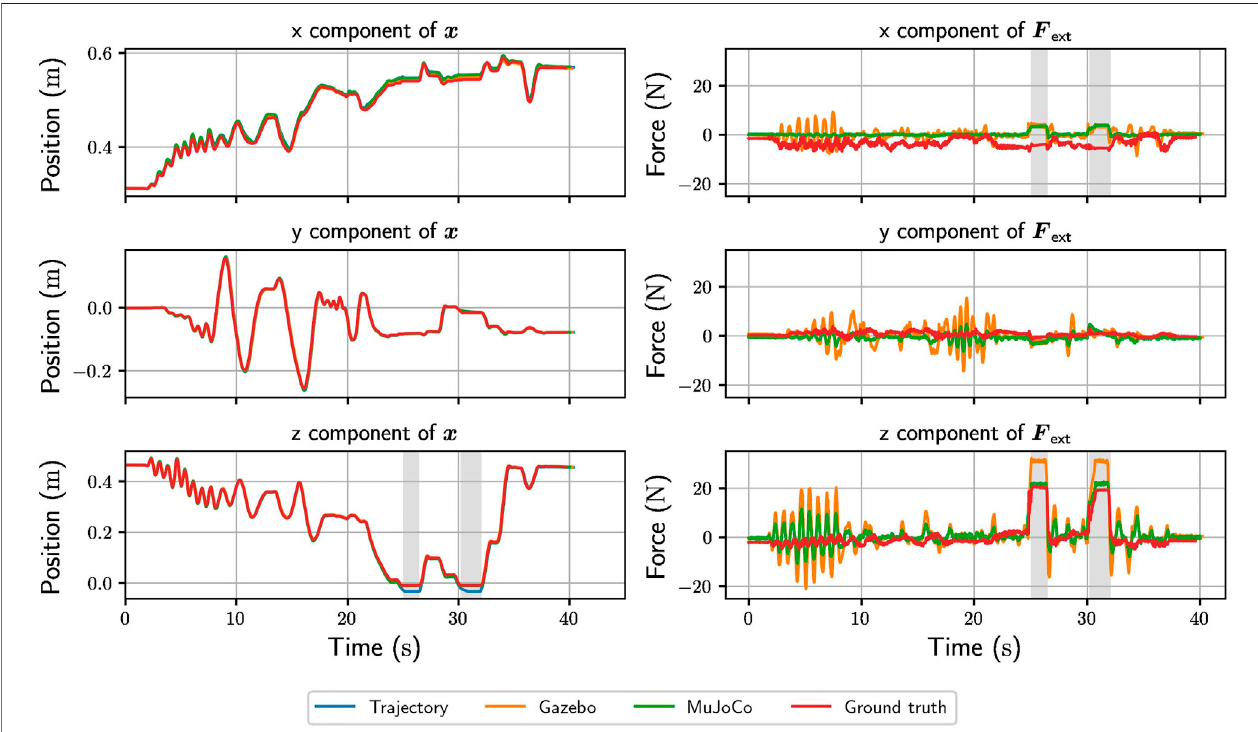
FIGURE6 | The left column ofgraphsshows the resulting end effector positions aswell asthe tracked trajectory for thesecond experiment, while the right column displaysthe respective models ’ estimated externalforces acting at the end effector during the sametime period. All quantities are expressed relative to the robot ’ s base frame. Periods of contact are highlighted by the grey vertical bars. Note that the robot is mounted 2 cm above the plane and contact is therefore established slightly below 0 on the z -axis while the reference trajectory reaches below the plane to facilitate solid contact wrenches given the controller ’ s impedance.